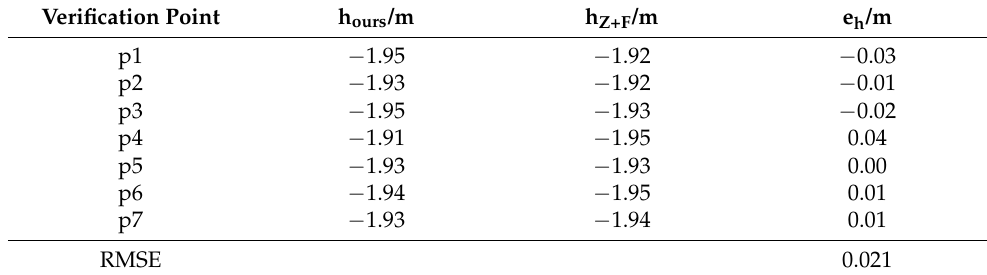
Table 2. Elevation accuracy comparison.